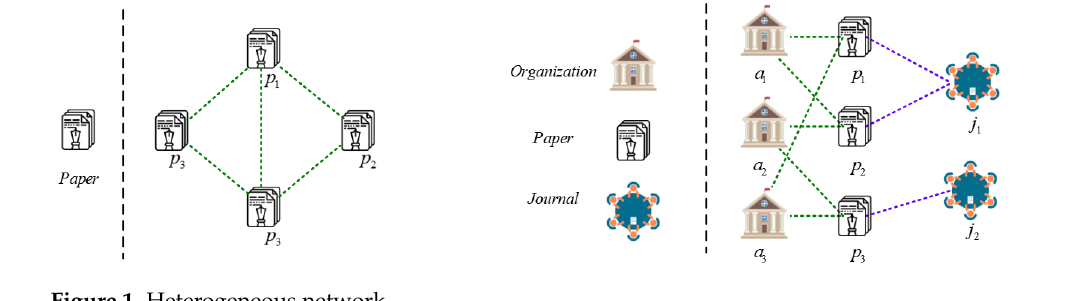
Figure 1. Heterogeneous